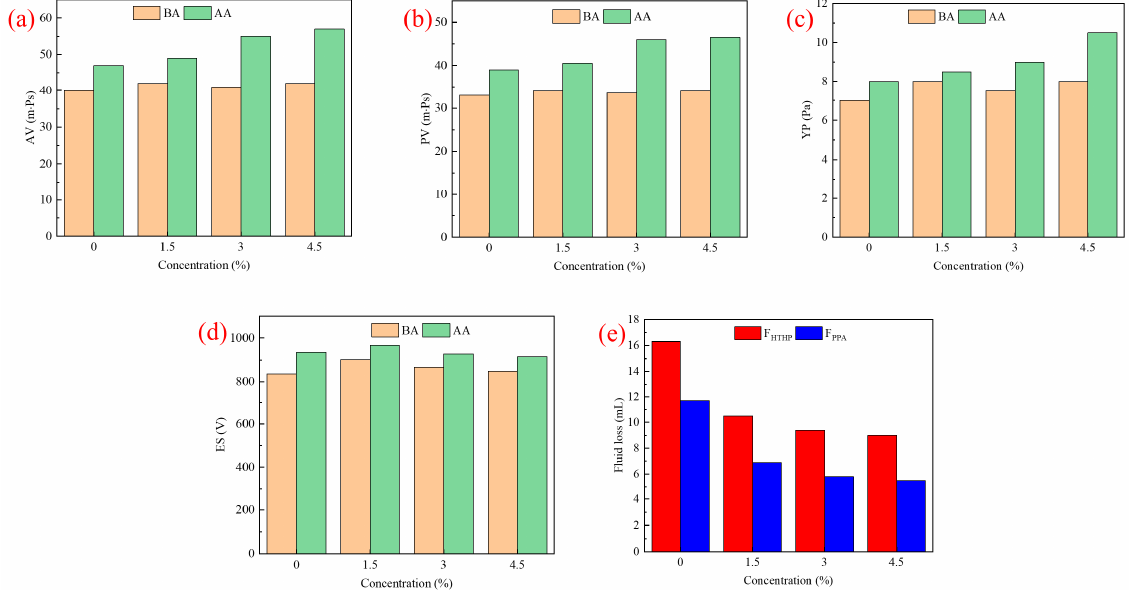
Figure 9. Values of the ( a ) AV, ( b ) PV, ( c ) YP, ( d ) ES and ( e ) F HTHP and F PPA of OBFs with different concentrations of AMND before and after aging (BA and AA) at 130 ℃ .